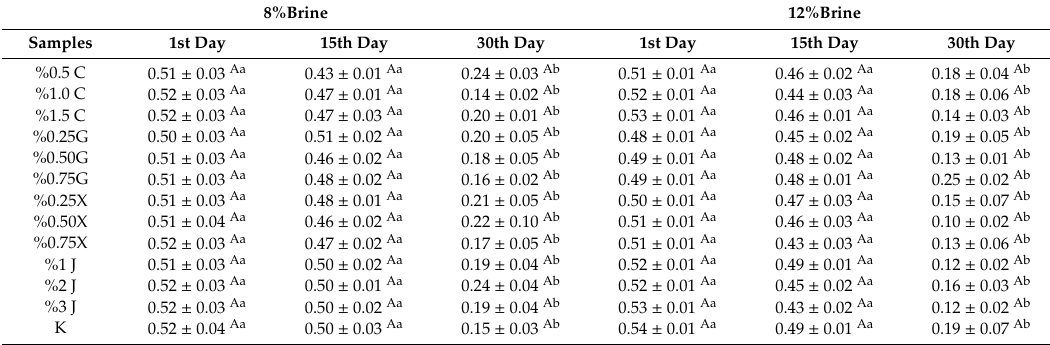
Table 11. Resilience (g) of cheese samples during